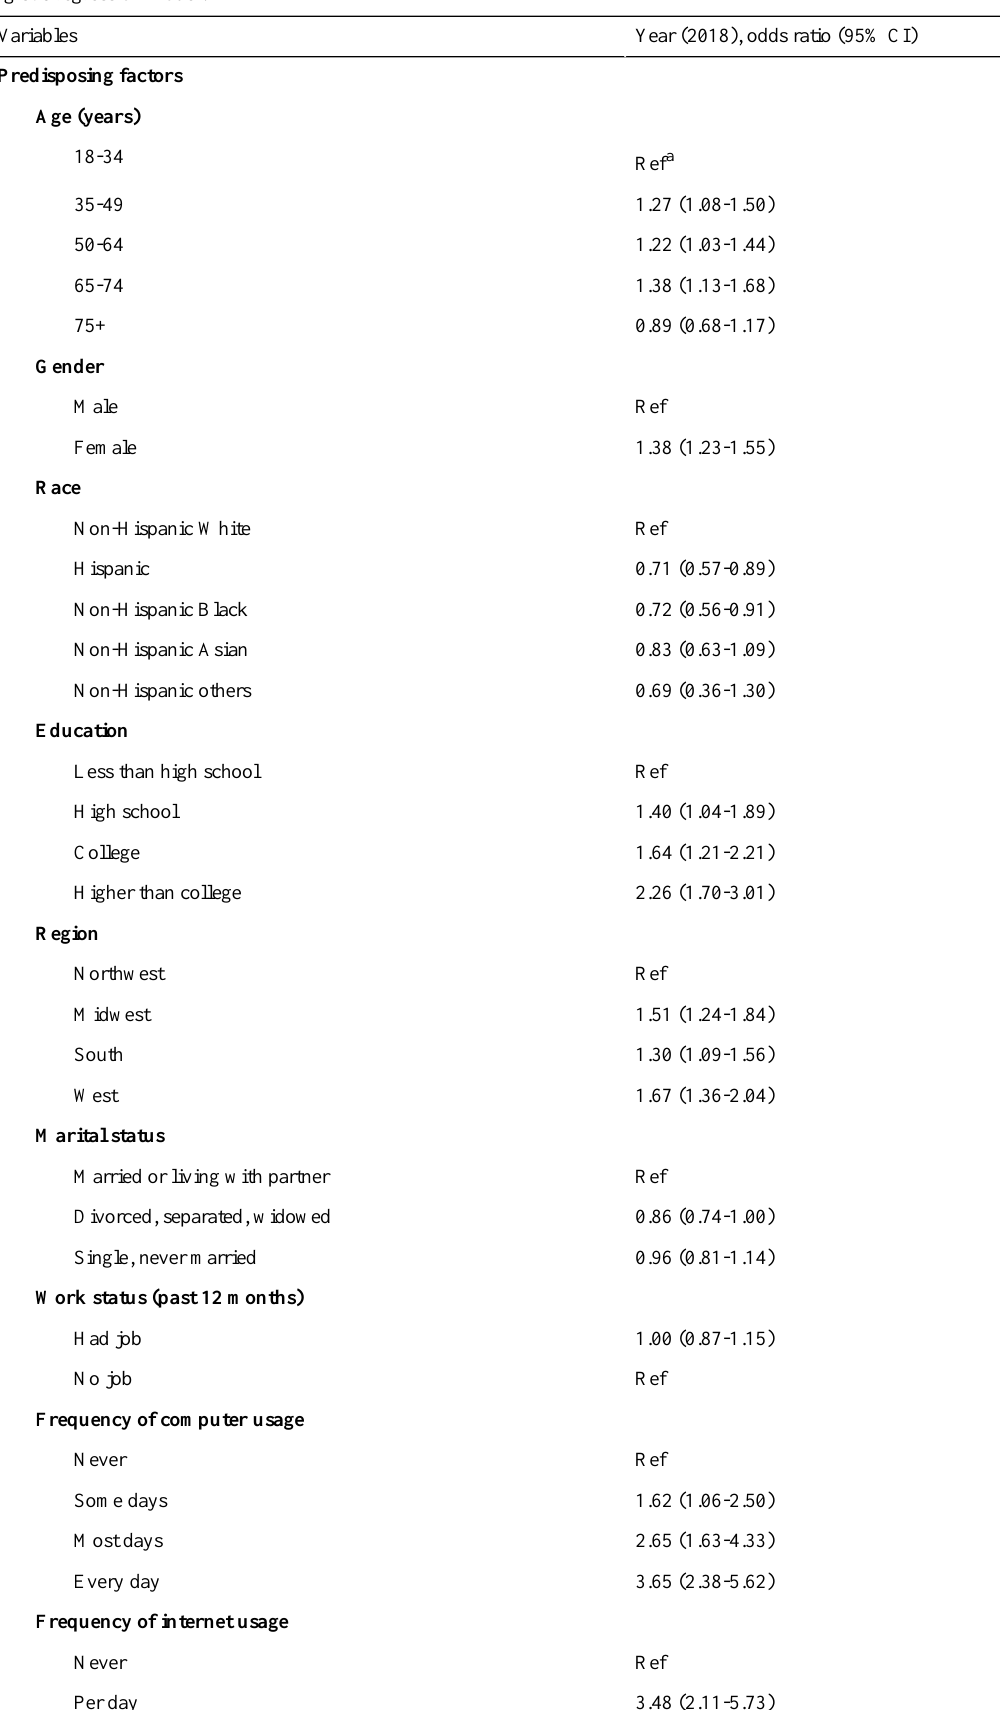
Table 2. Factors associated with web-based prescription-filling behavior among adults in the United States in 2018: results from the adjusted multivariable logistic regression